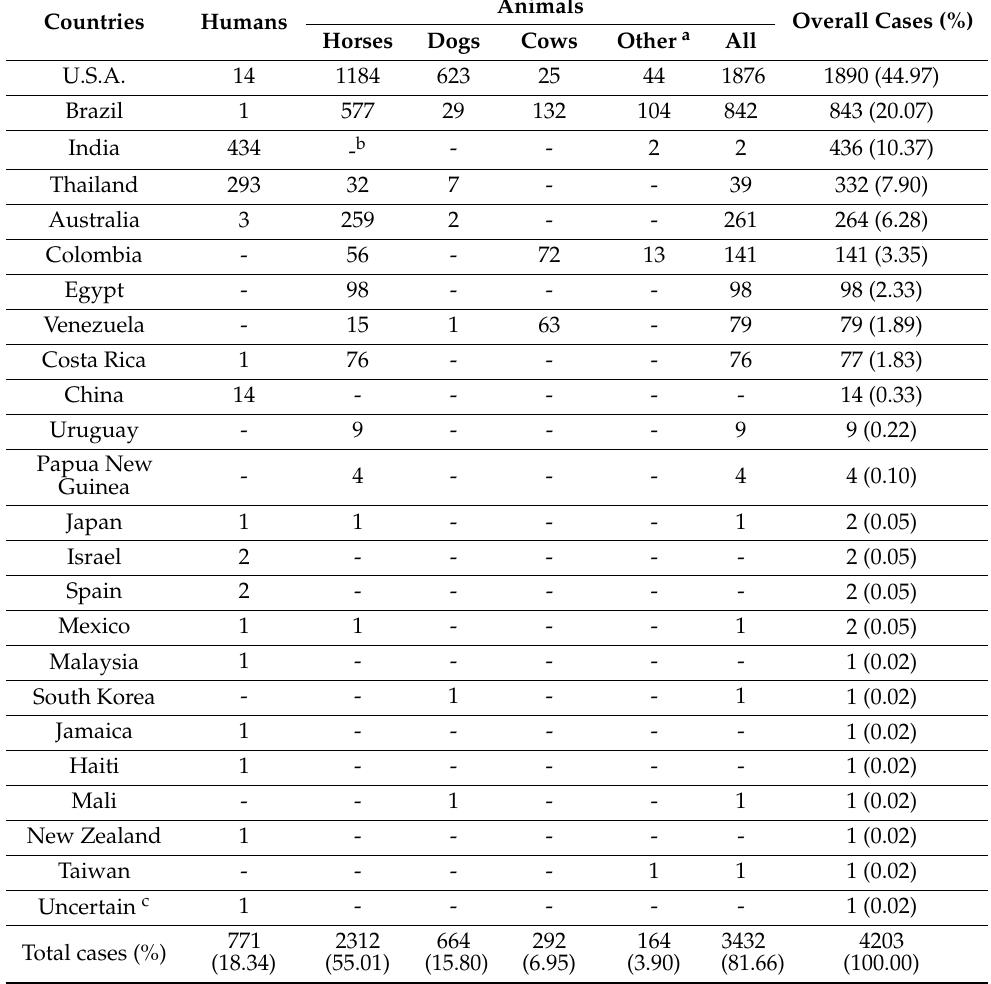
Table 1. Distribution of human and animal pythiosis in 23